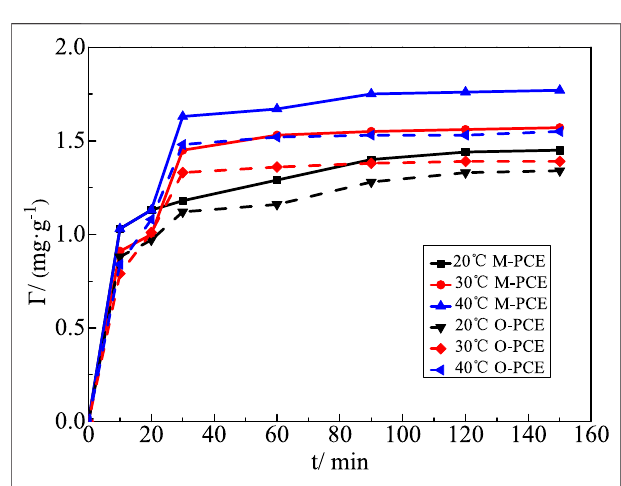
FIGURE 7 | Adsorbed amount of polycarboxylate molecules at different times and temperatures (0.2% dosage).